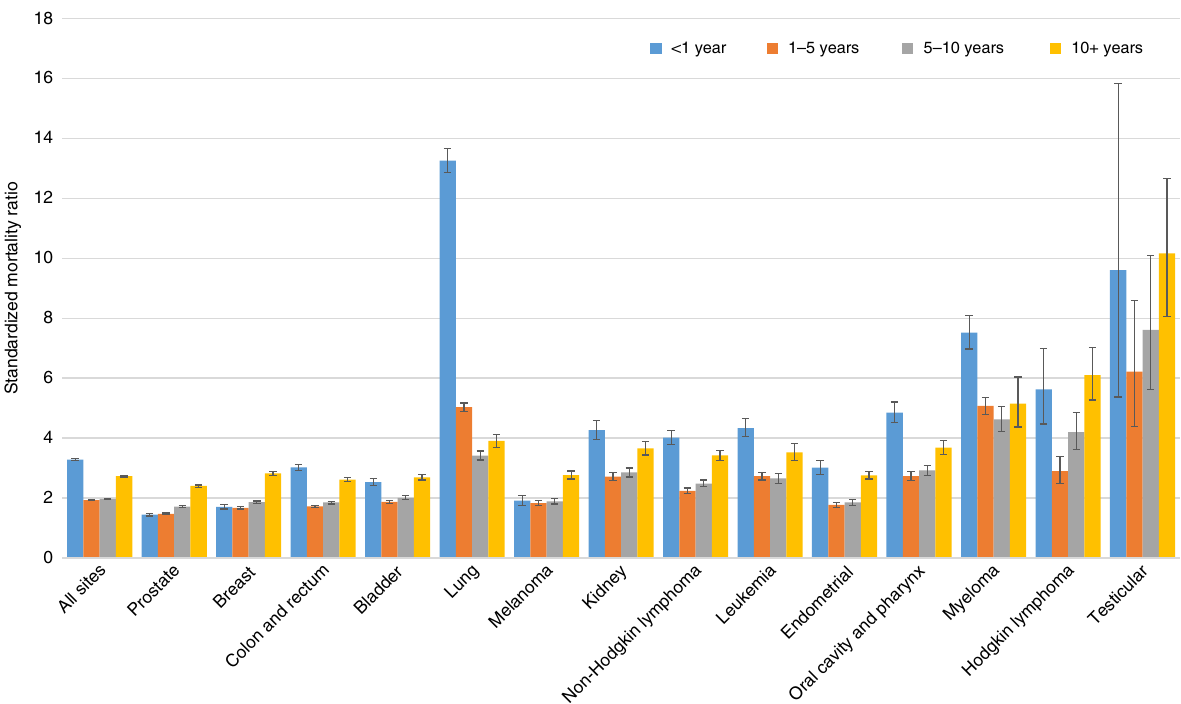
Fig. 1 Standardized mortality ratios (SMRs) of fatal heart disease among cancer patients by cancer subsite. The y-axis depicts the SMR with 95% CI, and the x -axis depicts the disease site. Different time periods after diagnosis (<1 year vs 1 – 5 years vs 5 – 10 years vs >10 years) are shown in blue, orange, grey, and yellow, respectively. At the 1 – 5 year post-diagnosis time point, the risk of heart disease among cancer patients is two times that of the general population and rises with longer follow-up time. Certain cancer patients have relatively high SMR from heart disease in the fi rst year after diagnosis (e.g. lung with SMR of 13.3, and myeloma with SMR of 7.5). These 12 cancer were chosen as they represent the sites with the greatest number of person – years at risk. Total person years at risk = 1,195,381.08. Error bars represent the 95% CI by site. Source data are provided as a Source Data fi